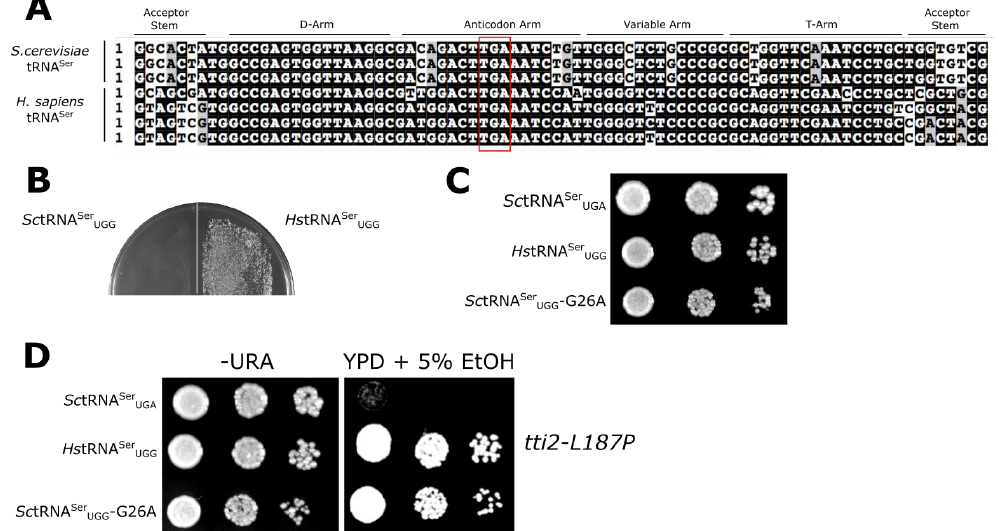
Figure 1 . Human ( Homo sapiens ) tRNA SerUGA functions inefficiently in Saccharomyces cerevisiae . ( A